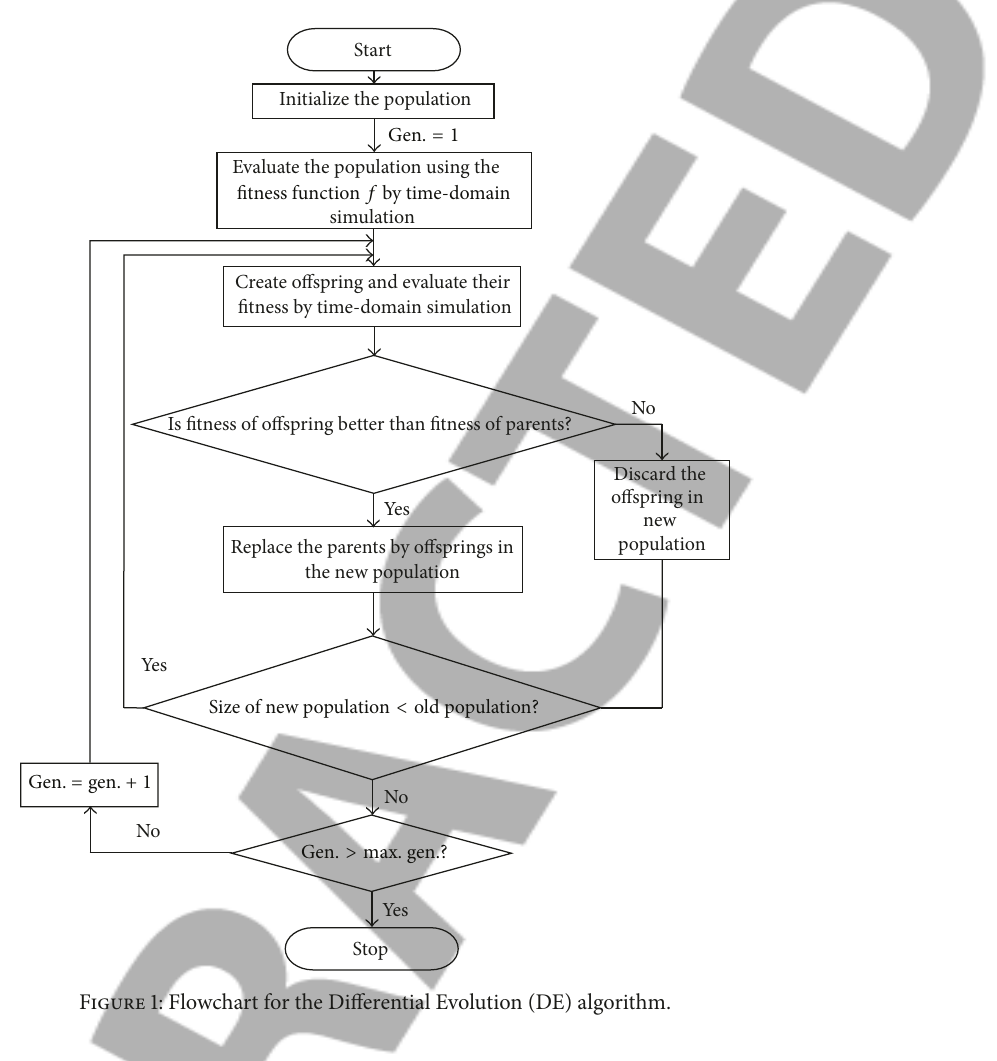
Figure 1: Flowchart for the Differential Evolution (DE)